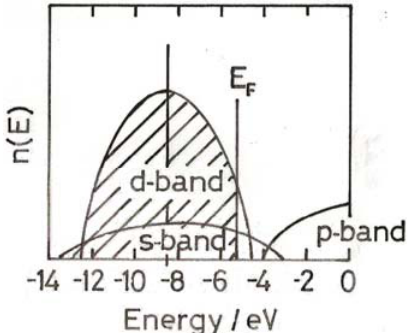
Figure 2. Distribution of energy levels for a very small (2 nm) particle, with a band gap above the Fermi